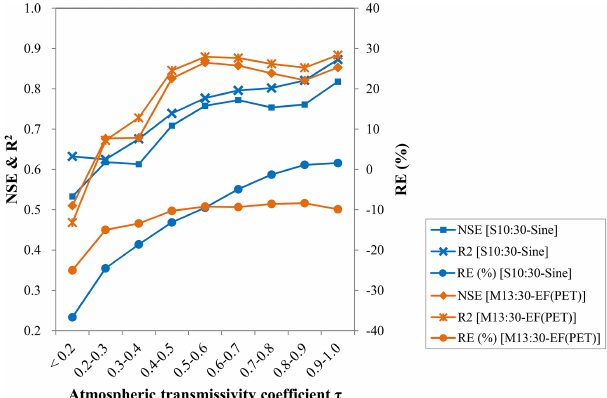
Figure 7. Overall evaluation of the sine function method simulated by a single-time value of 10:30 and the EF(PET) method simulated by multi-time values at 13:30 for all sites under differing daily at- mospheric transmissivity coefficients.